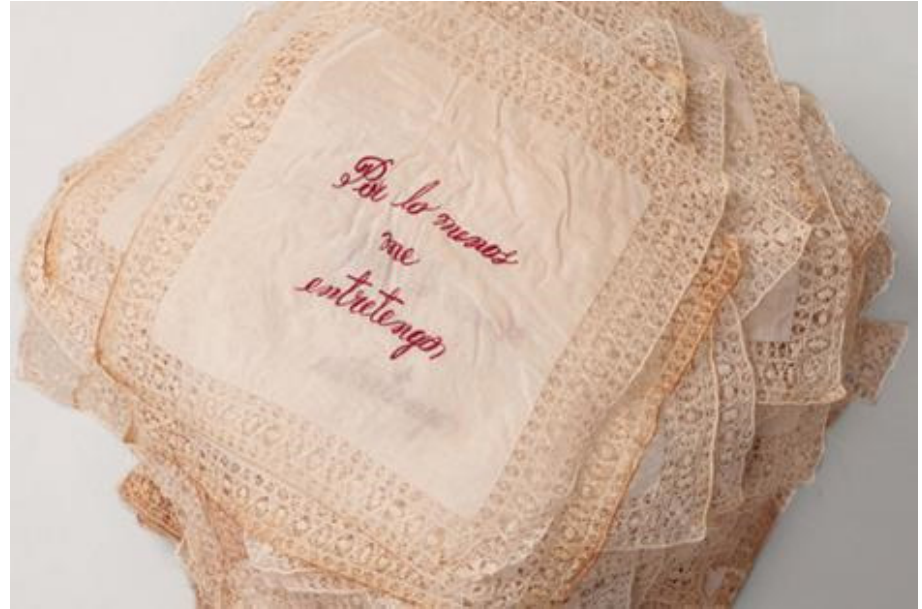
Figure 4. Jessica Sofía Mitrani, At least I Entertain Myself (2011). Image provided by the